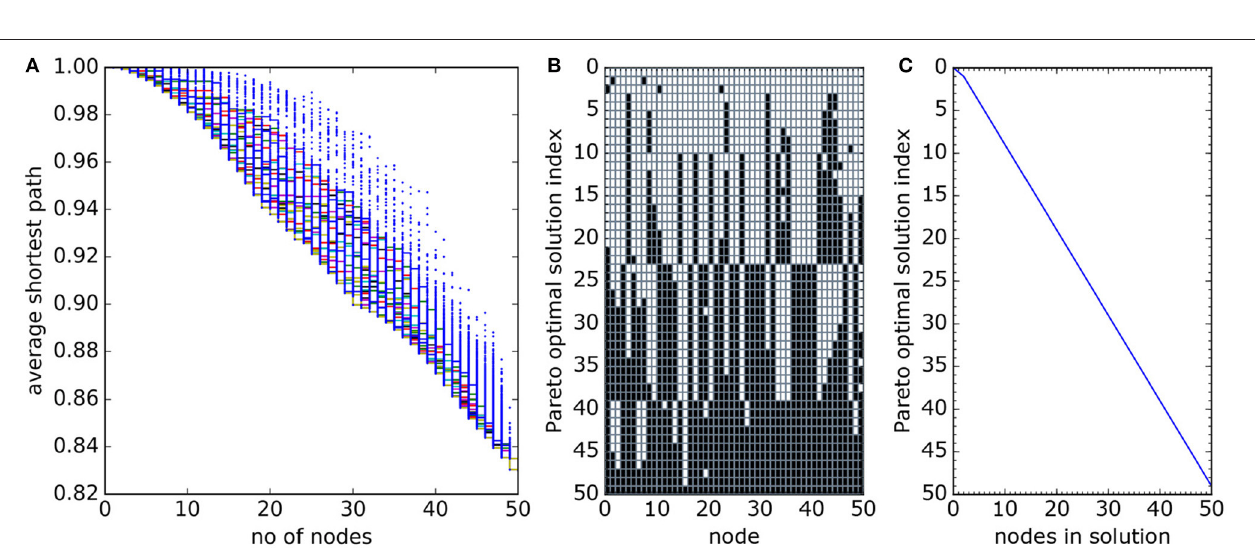
FIGURE 7 | Four of the “preferred” Pareto-optimal solutions (indicated by the circles in Figure 6A ) for the Scottish MPA network ( Figure 3 ) in order of increasing cost (A–D) . Red and pink circles show sites included in and excluded from the network, respectively.